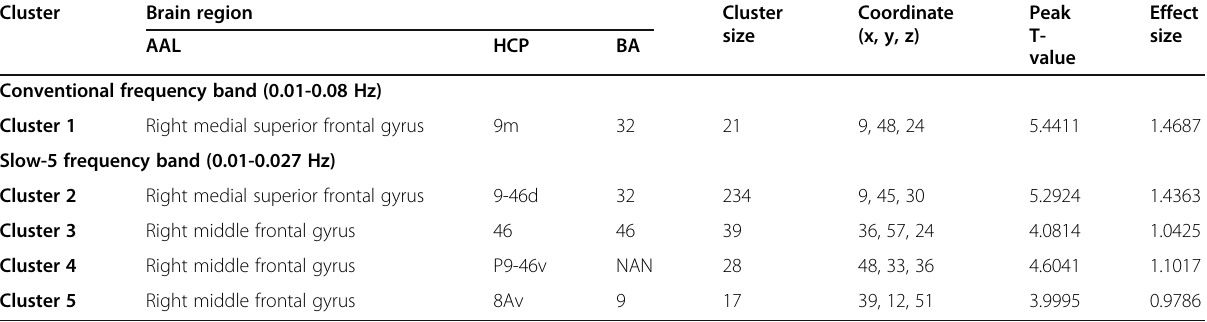
Table.2 The regional homogeneity difference in each frequency band between tension-type headache patients and healthy